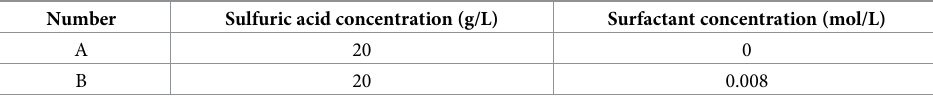
Table 2. Experimental